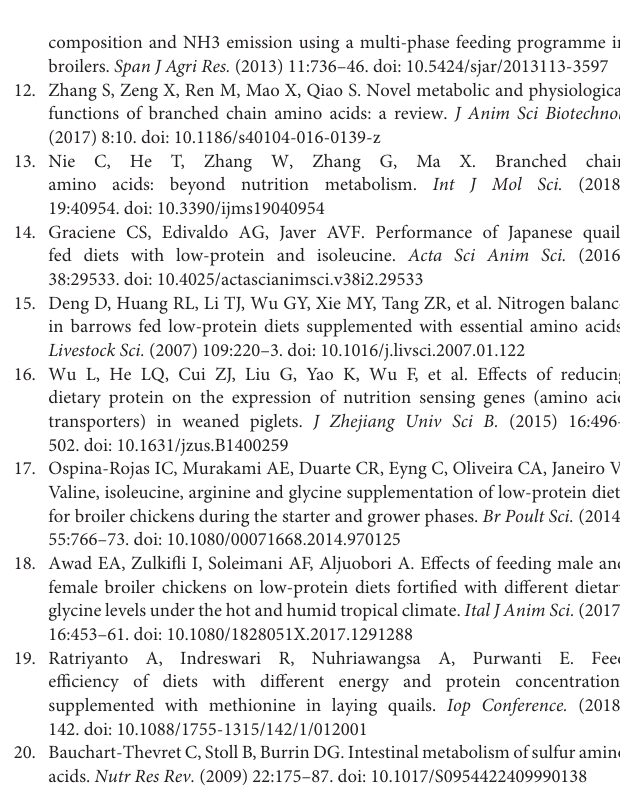
Supplementary Figure 1 | The effects of different dietary Met supplementation in low protein diets on the difference of the gut microbiota of laying hens. (A) The LEfSe analysis of the gut microbiota in the four treatments. (B) The mean proportion of the gut microbiota in the four treatments. Supplementary Table 1 | Ingredients and nutrient content of the diets (% DM). Supplementary Table 2 | Regression equation between production performance and Met and sulfur-containing amino acid intake. Supplementary Table 3 | The proportion of gut microbiota within the four Met groups on genus